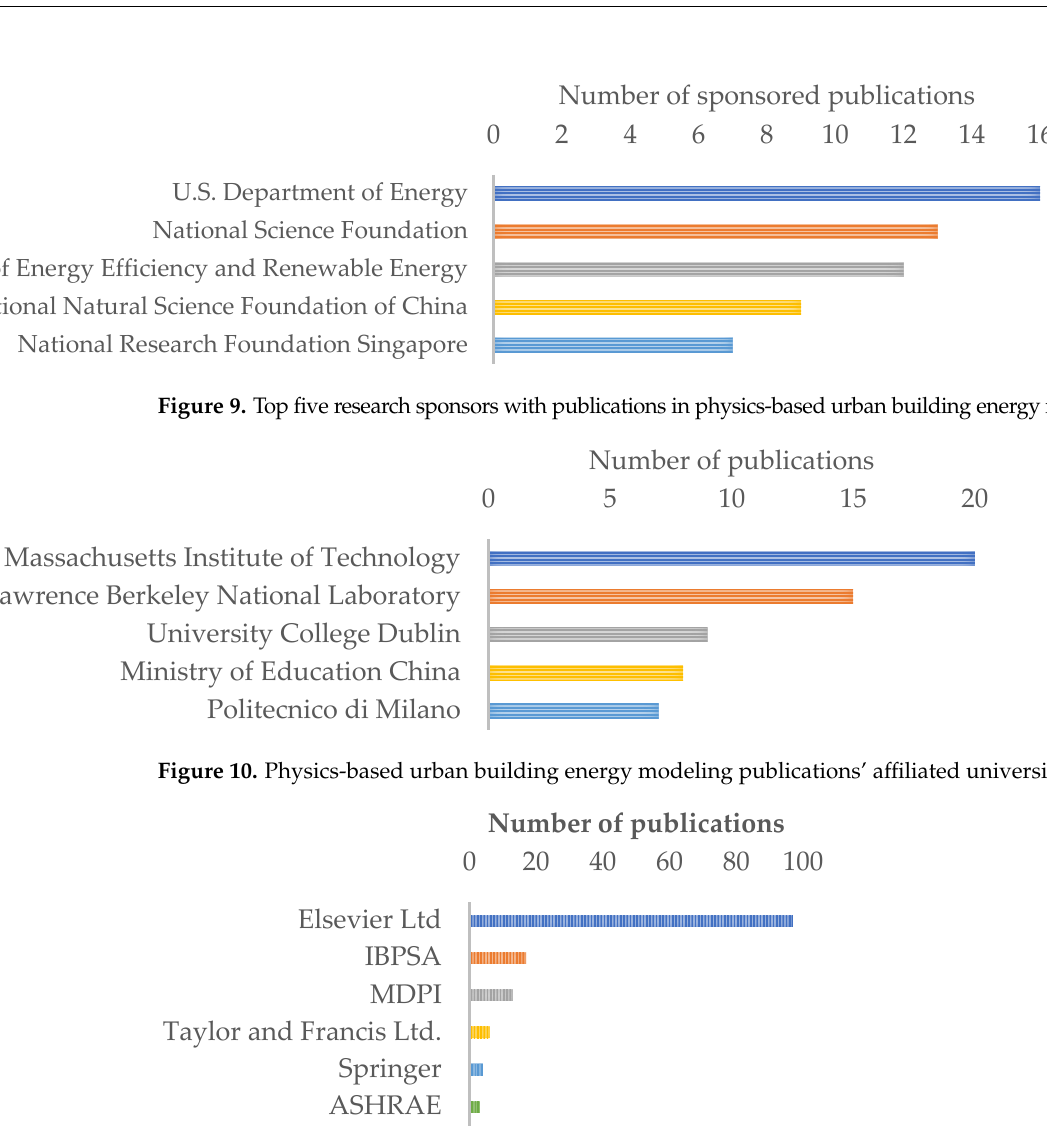
Figure 11. Publishers with a minimum of three publications in physics-based urban building energy modeling selected for this review paper.